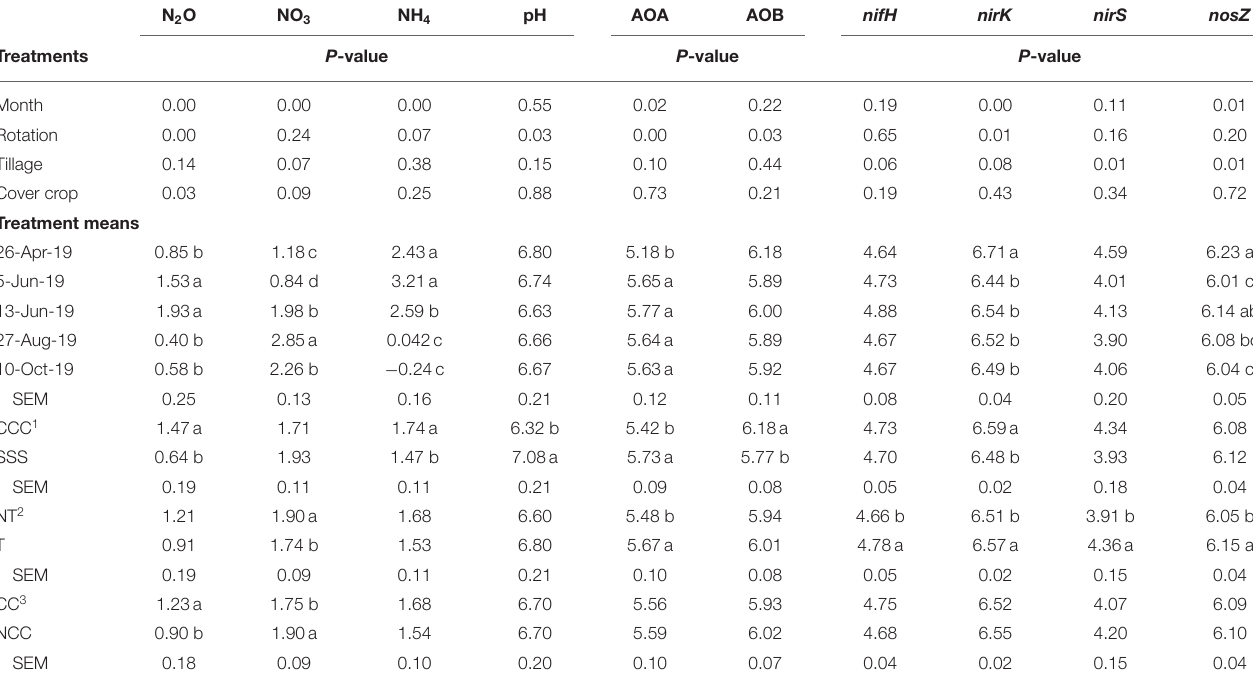
TABLE 2 | Analysis of variance (ANOVA) results for the main effects of month, crop rotation, tillage, and cover crop on nitrous oxide (N 2 O, g N 2 O-N ha − 1 day − 1 ), available nitrogen